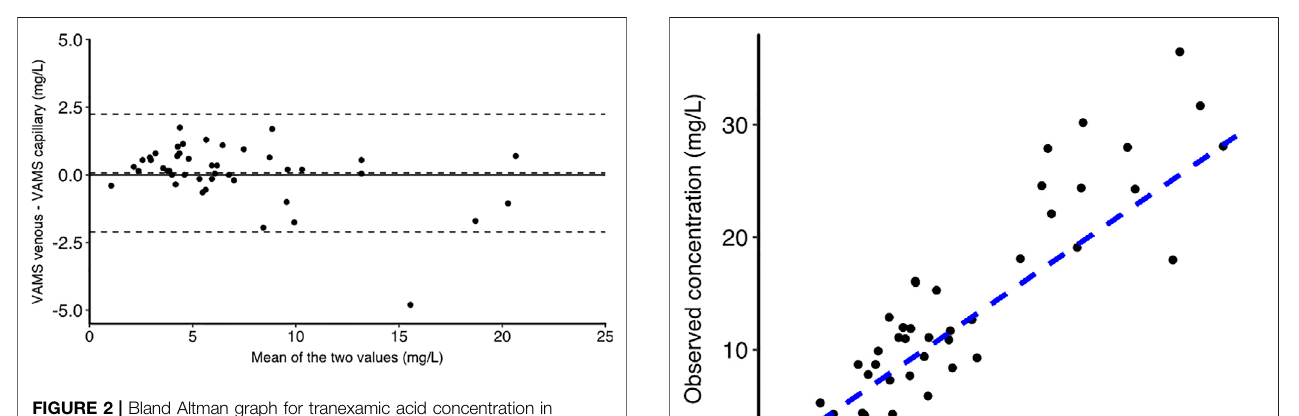
FIGURE 2 | Bland Altman graph for tranexamic acid concentration in mg/L measured in VAMS samples of venous and capillary blood. The bias, lower and upper limits of agreement are at 0.07, − 2.1 and 2.2 mg/L respectively ( n (cid:1) 44).